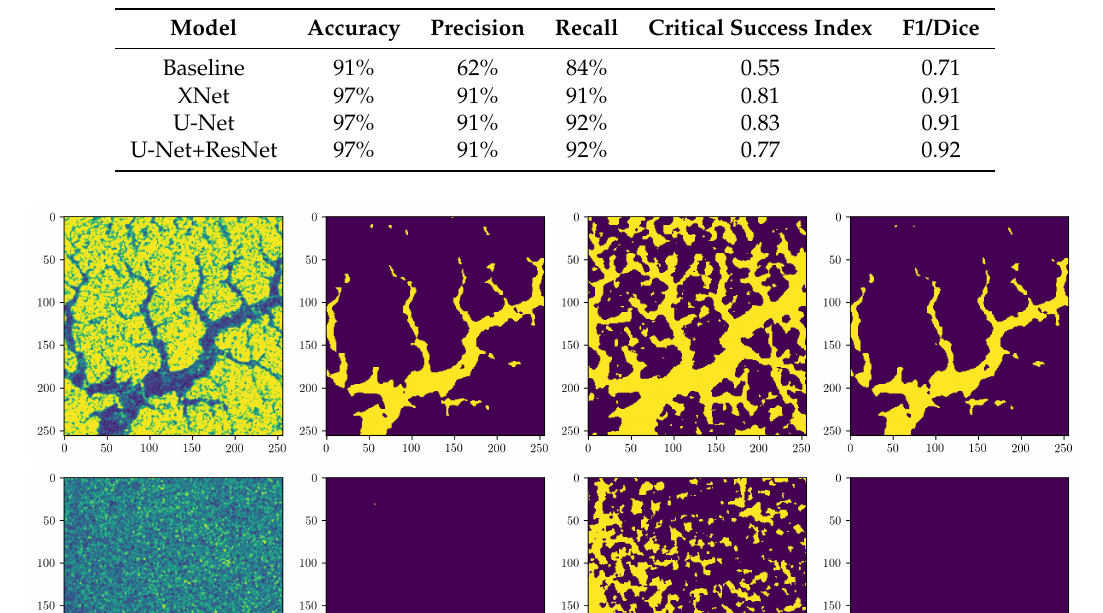
Table 4. Overall quantitative comparison.